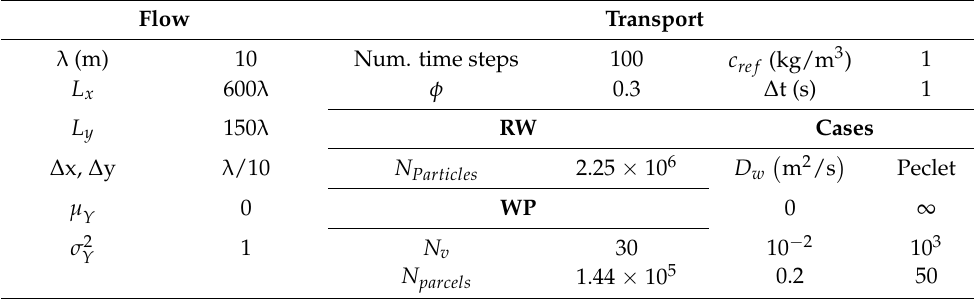
Table 1. Flow and transport problem parameters and simulation